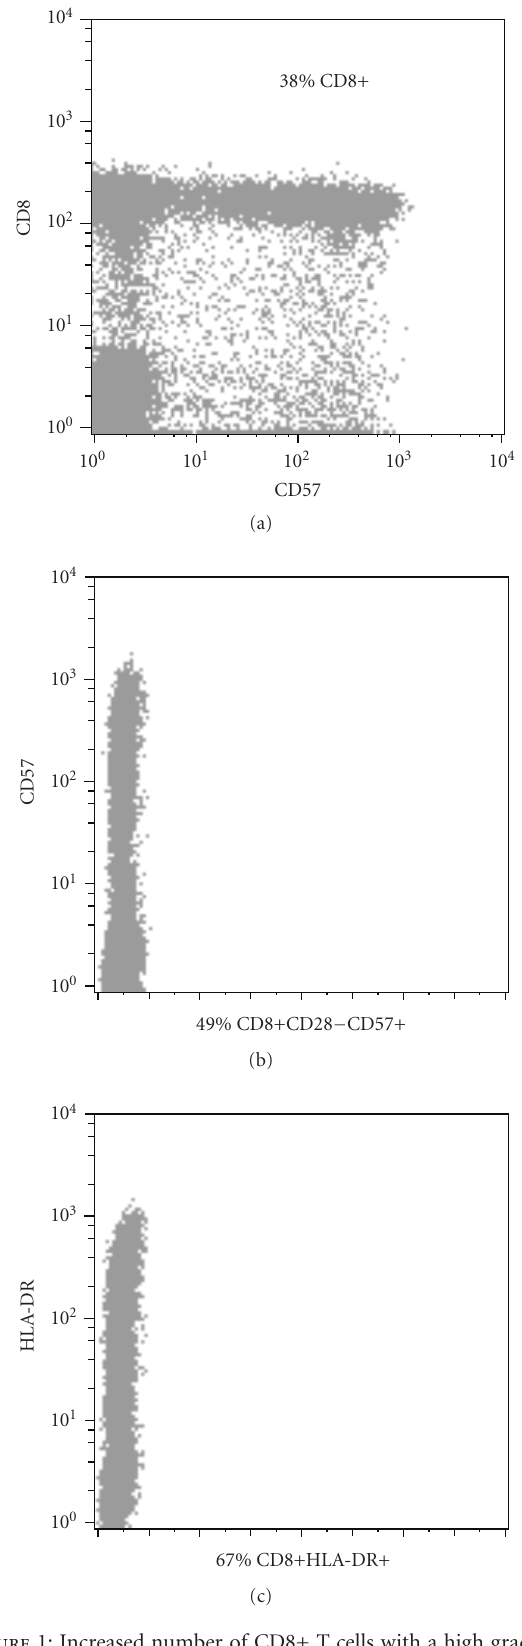
Table 1: T cells, B cells, and NK cells counts by flow cytometry in whole peripheral blood.